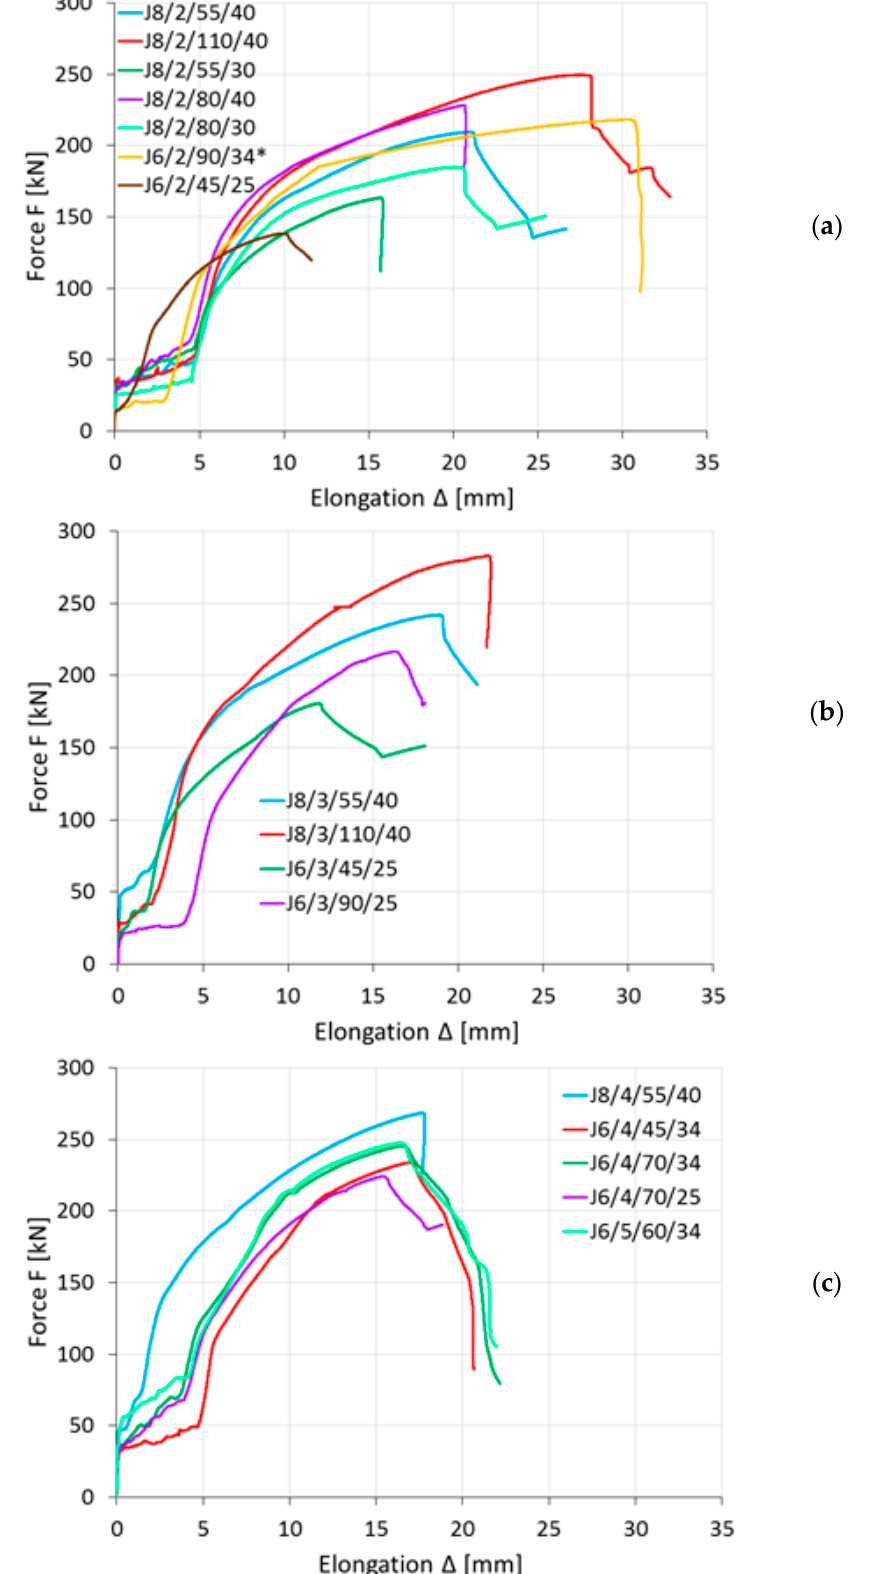
Figure 4. Load–elongation diagrams: ( a ) connections with 2 bolts, ( b ) connections with 3 bolts, ( c ) connections with 4 or more bolts (*: elongation in this case was measured by machine clamps).